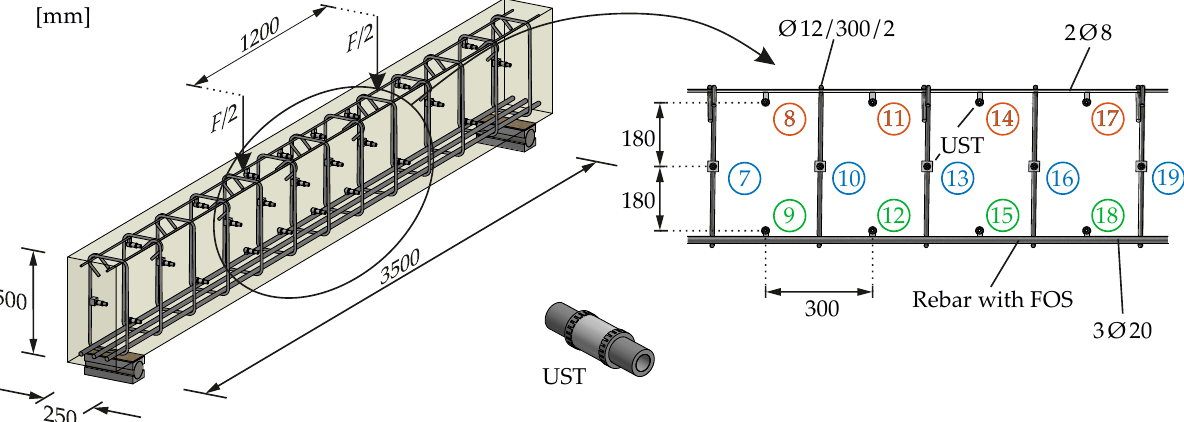
Figure 4. Beam geometry, reinforcement layout and loading along with the US transducer (UST)